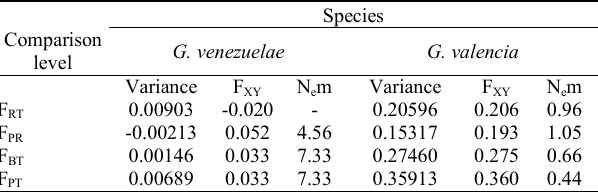
Table 4. Variance components and hierarchical F statistics for all loci of G. venezuelae and G. valencia . Negative values are considered non-defined and are the result of higher intra- population (as opposed to inter-population) variability (Lessios et al. ,